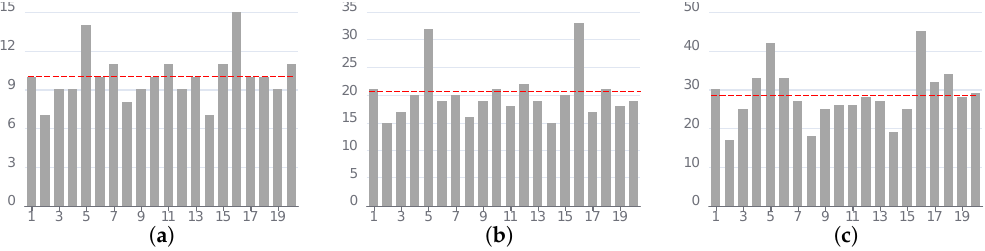
Figure 12. Objective performance of participants in experiments. The red line represents the average value of each variable. ( a ) Number of new patterns. ( b ) Number of queries. ( c ) Completion time. Two participants took more than 40 minutes (Figure 12c) to complete the